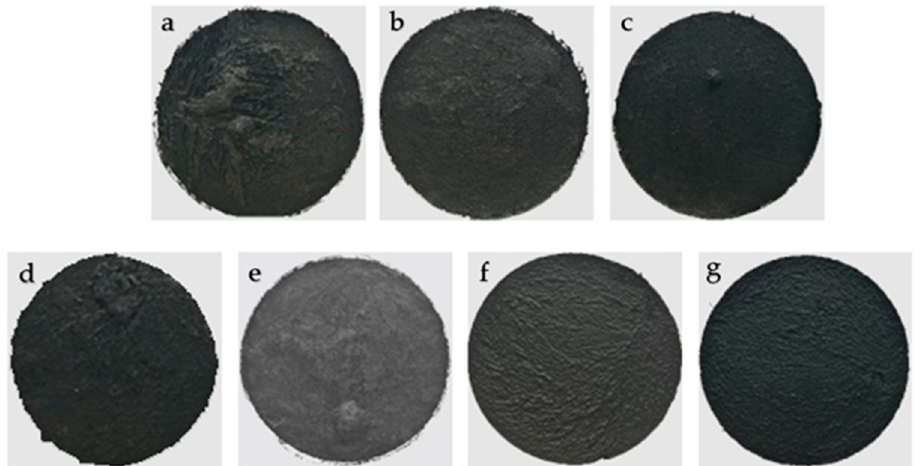
Figure 3. Photographs of CCGA prepared via various ultrasonic conditions of ( a ) 600 W, 40 min; ( b ) 800 W, 40 min; ( c ) 1000 W, 40 min; ( d ) 1000 W, 10 min; ( e ) 1000 W, 30 min; ( f ) 1000 W, 50 min; ( g ) 1000 W, 70 min.